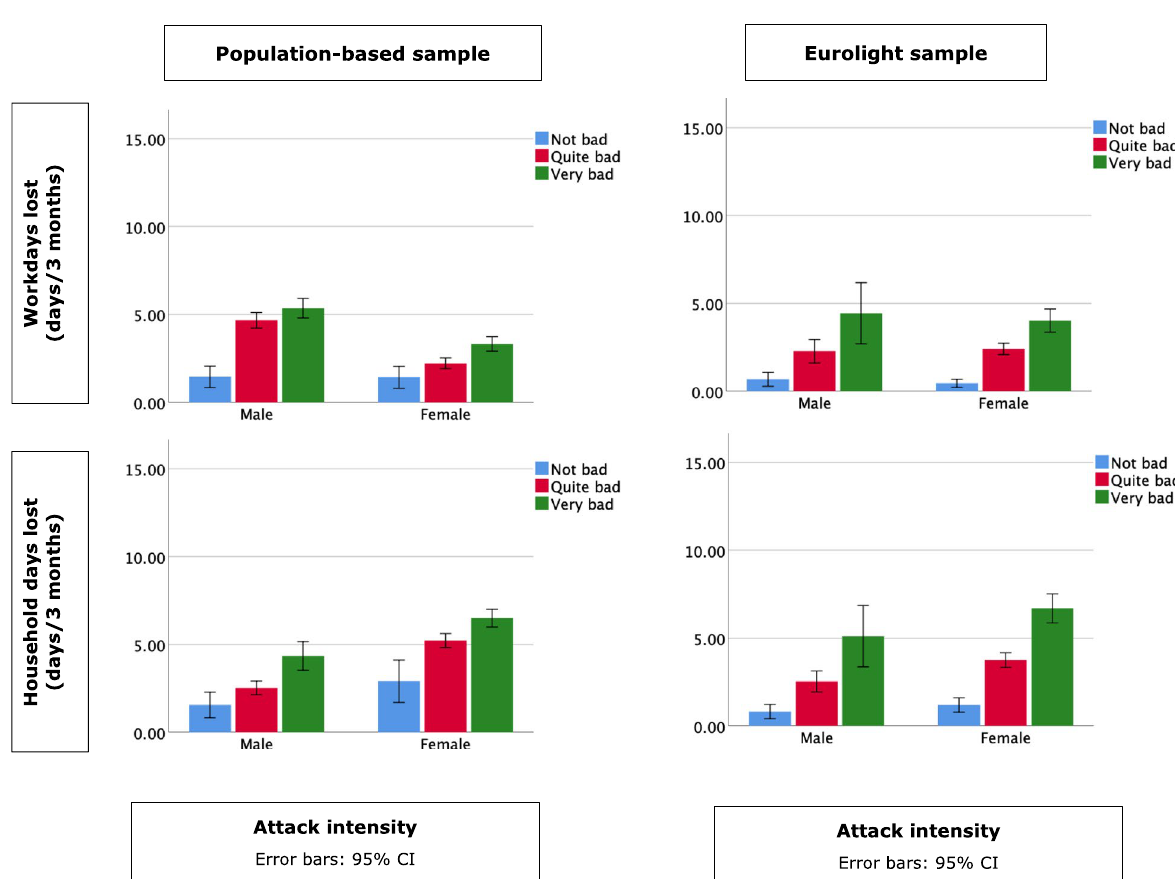
Fig. 3 Relationship between lost productivity (work days and household days) and attack intensity by sample and gender. The Y axis is on the same scale as in Fig. 1 for ease of